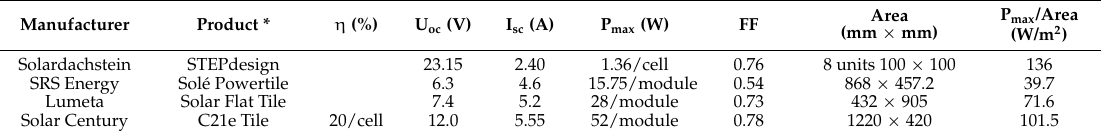
Table 2. Literature data for some of the BIPV tile products [3].